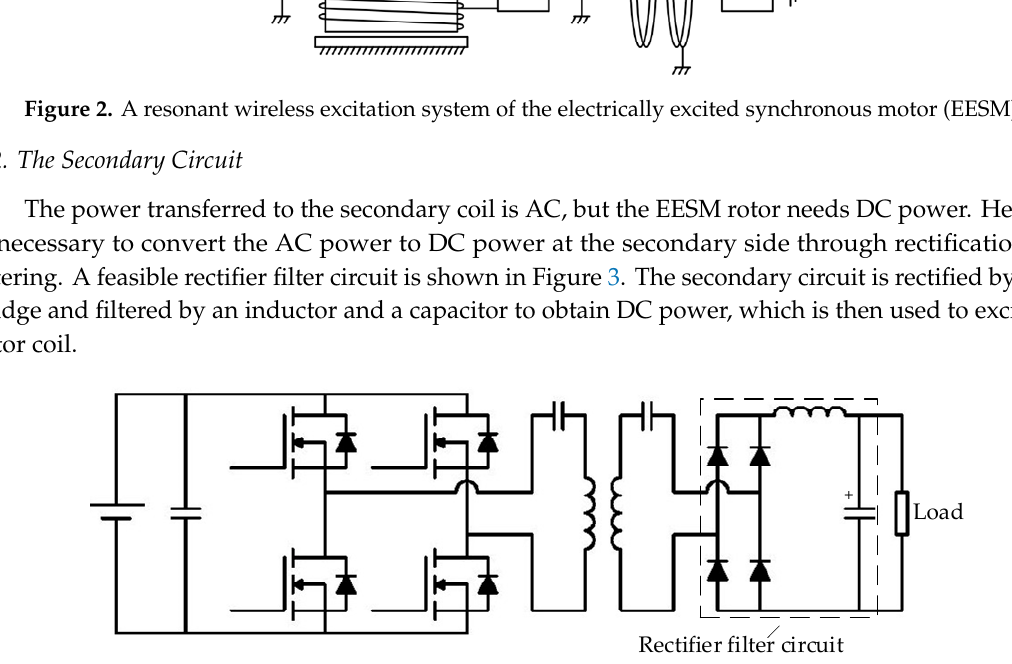
Figure 3. The resonant wireless power transfer system.